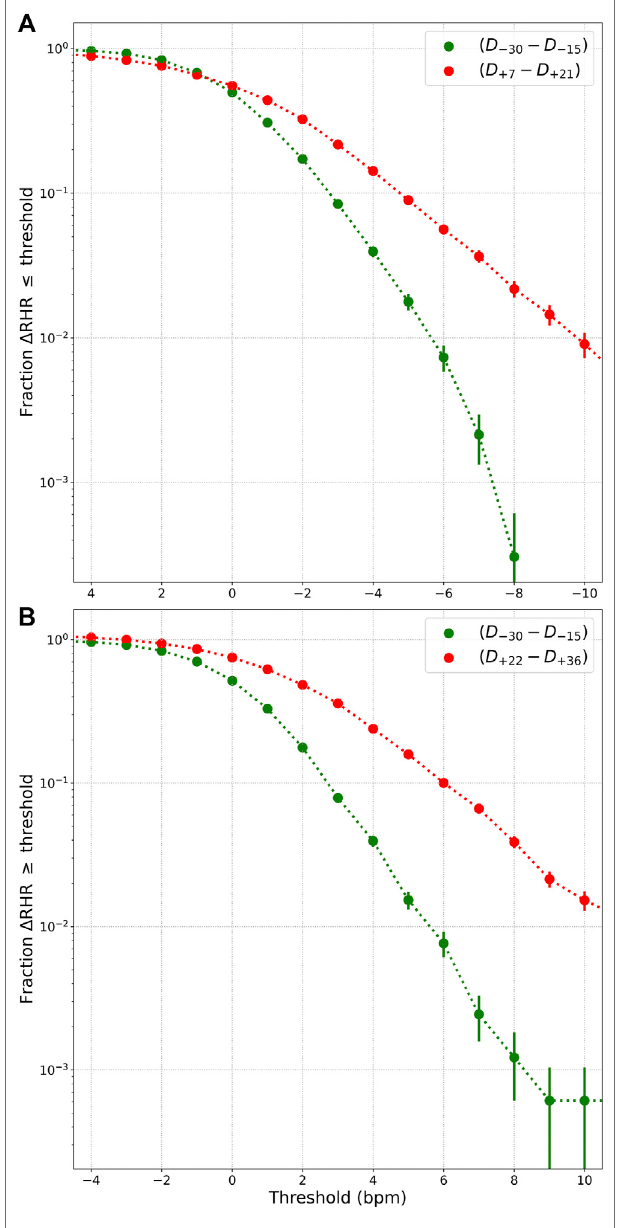
FIGURE 5 | (A) Fraction of individuals with Δ RHR ≤ x in the relative bradycardia window (red points), where x is a threshold, compared to the fraction that could be expected due to chance (green points). (B) shows the fraction of individuals with Δ RHR ≥ x in the relative tachycardia window (red points), compared to the fraction that could be expected due to chance (green points). Δ RHR is the excess RHR compared to the control window. Error bars show standard error of the mean.